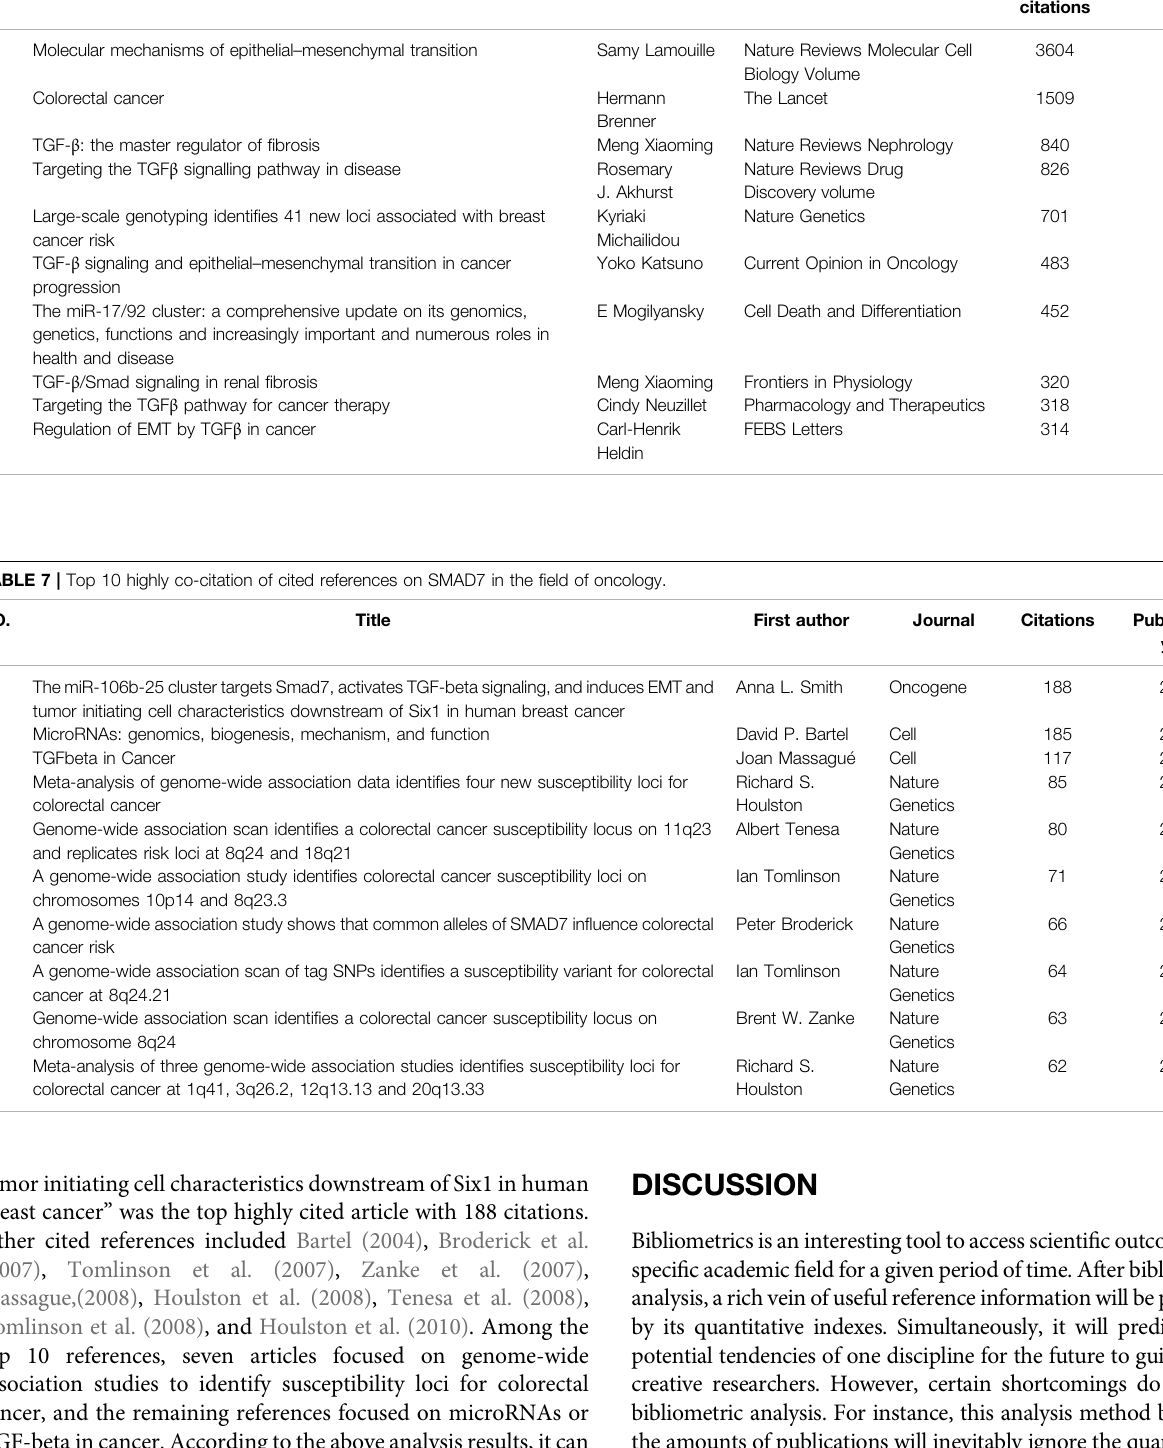
TABLE 6 | Top 10 highly cited documents on SMAD7 in the fi eld of oncology. NO.